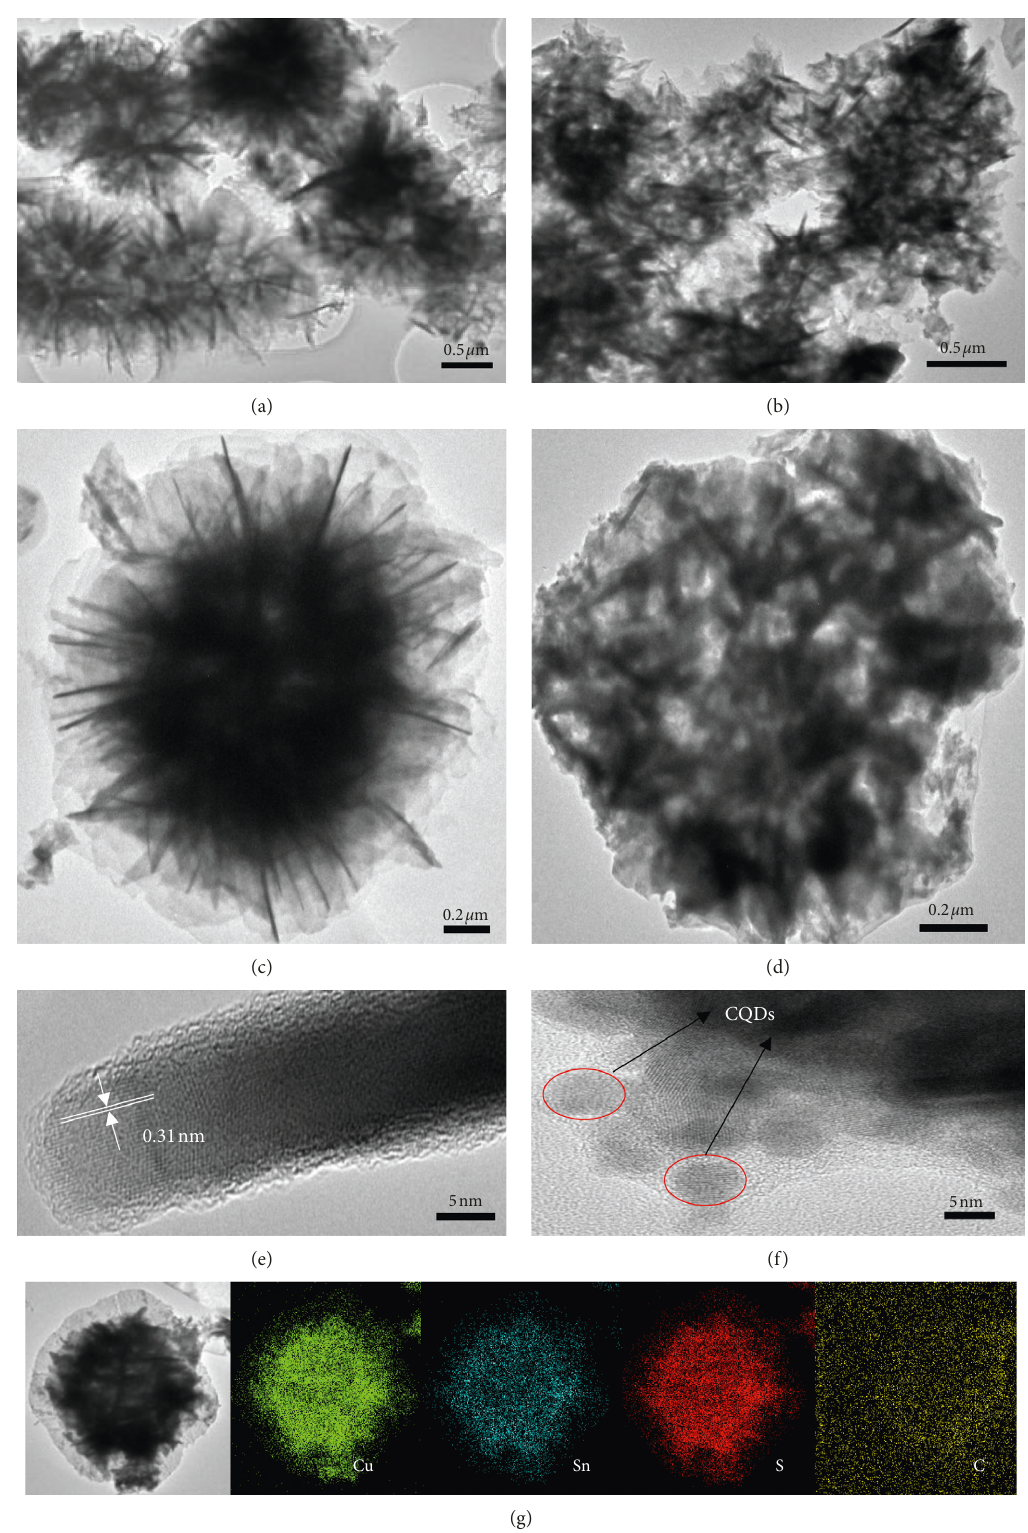
Figure 2: Characteristic TEM images of (a, c) CTSs and (b, d) CTSs@CQDs at low and high magnification. HRTEM images of (e) CTSs and (f) CTSs@CQDs. (g) TEM image of CTSs@CQDs and corresponding elemental mapping